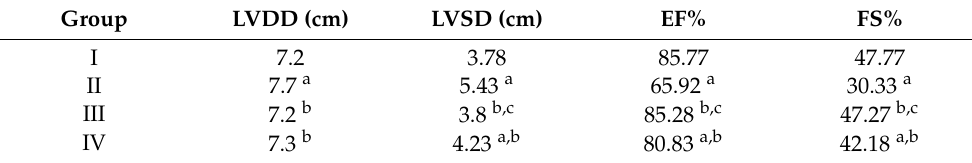
Table 1. Echocardiography results for different study groups.